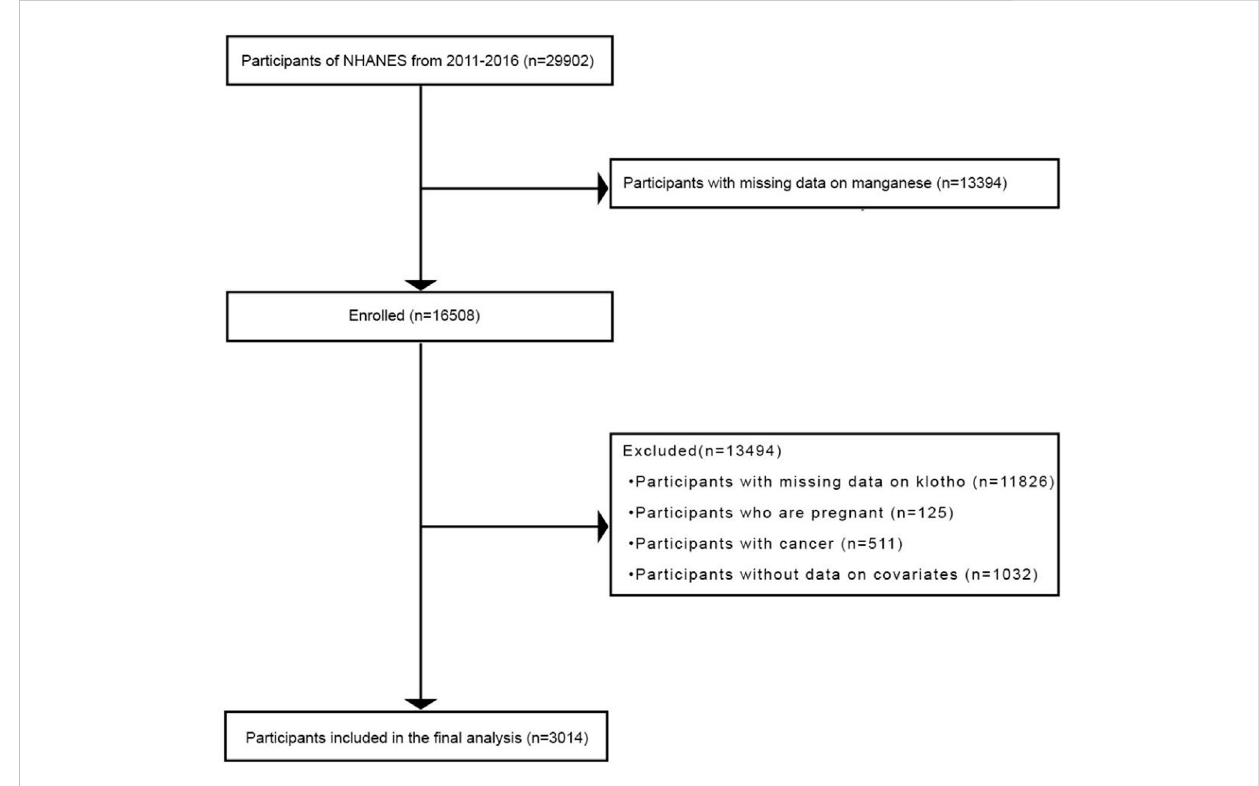
FIGURE 1 Flowchart depicting the process of participant recruitment in this